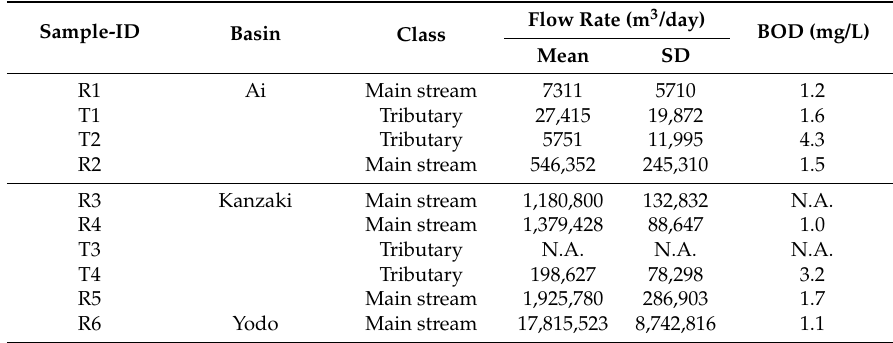
Table 2. Information of flow rate and biological oxygen demand (BOD) values at the sampling sites in the Kanzaki–Ai River basin (Figure 1) (reproduced from the data in [30]).